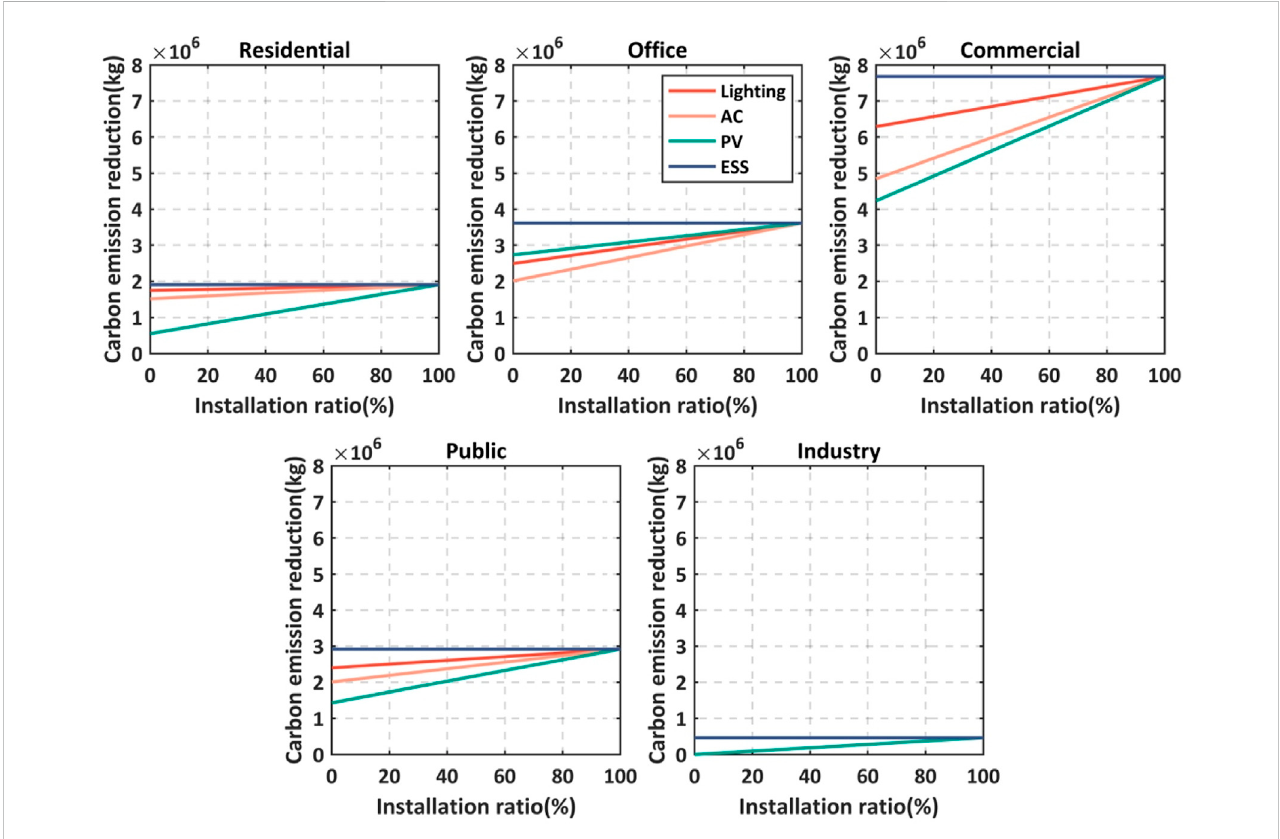
FIGURE 12 Relationship between carbon emission reduction and equipment installation ratio.